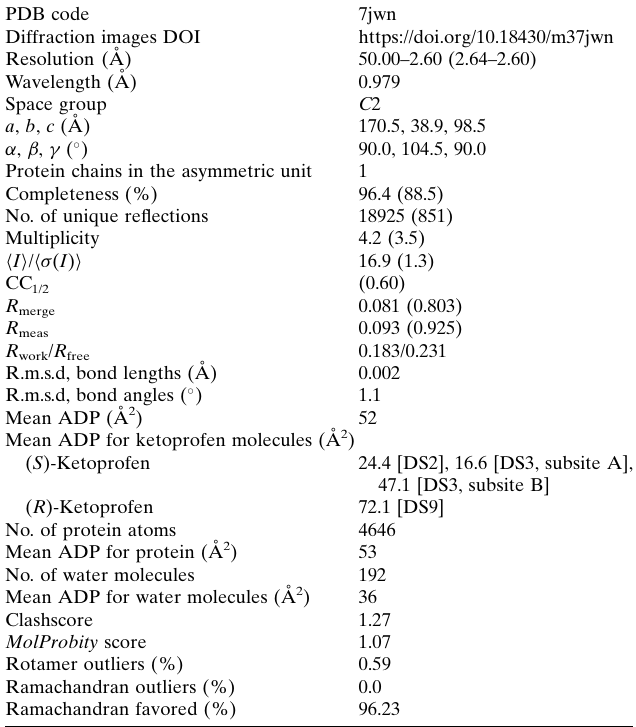
Table 1 Data-collection, structure-refinement and structure-quality statistics. Values in parentheses are for the highest resolution shell. Ramachandran plot statistics are calculated by MolProbity (Williams et al. , 2018). DS2, DS3 and DS9 refer to drug-binding sites 2, 3 and 9,